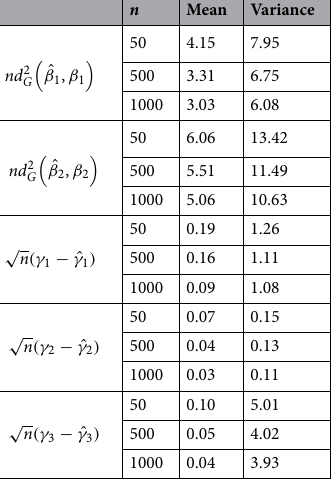
γ l ) in Theorem 1. − ˆ